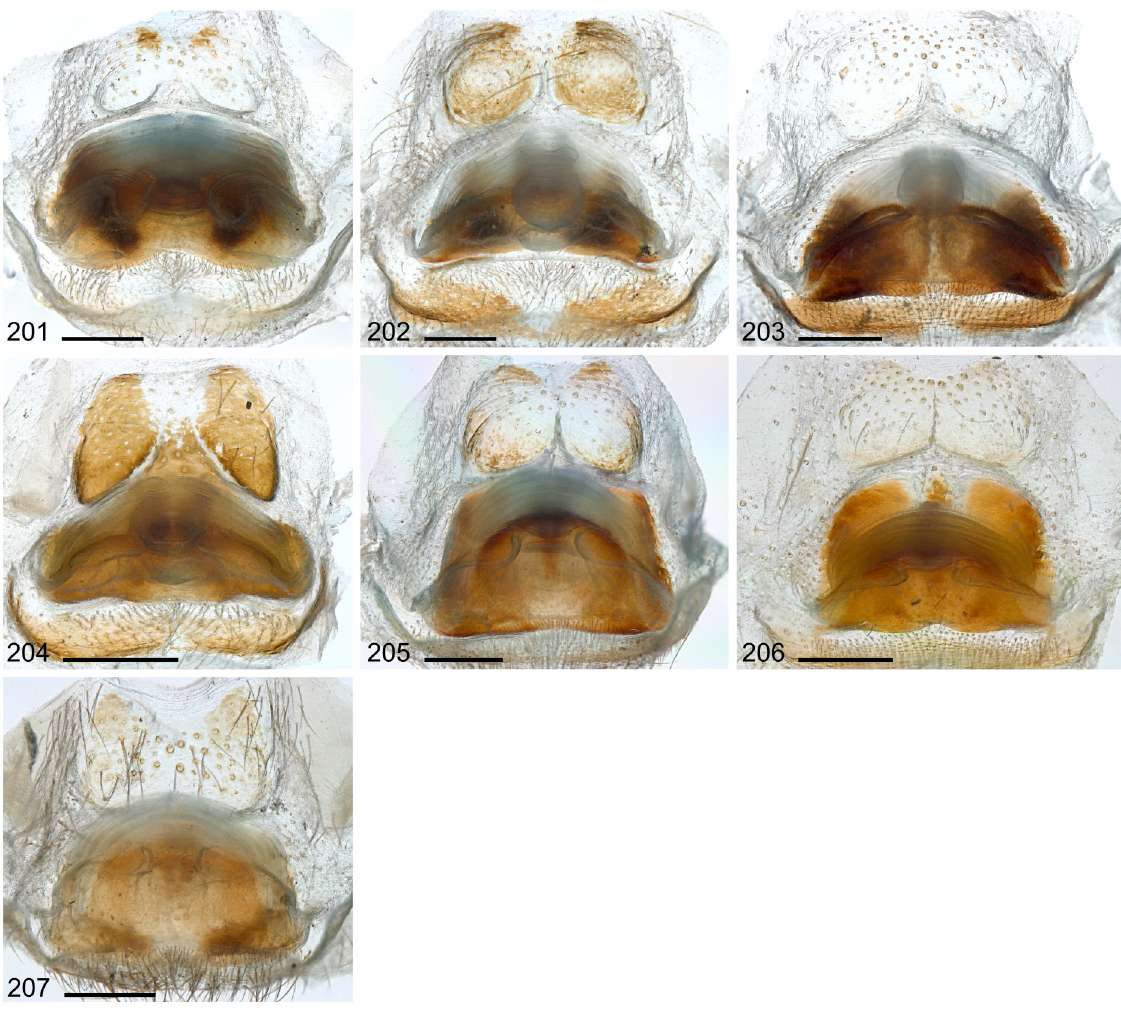
Figs 201–207. Cleared female genitalia, dorsal views. 201 . Artema atlanta Walckenaer, 1837 (AMNH, USA, Arizona, Tucson). 202 . A. bunkpurugu Huber & Kwapong, 2013 (ZFMK Ar 10516, Ghana, Bunkpurugu-Nakpanduri). 203 . A. nephilit sp. nov. (HUJ Ara 16020, Israel, Samar). 204 . A. kochi Kulczyński, 1901 (MNHN AR 10169 part). 205 . A. doriae Thorell, 1881 (ZFMK Ar 15234, Iran, Tehran Prov., Tochal). 206 . A. transcaspica Spassky, 1934 (ZIN type vials). 207 . Artema sp. c. (ZMMU, Pakistan, Baluchistan, Muslim Bagh). Scale lines: 0.5